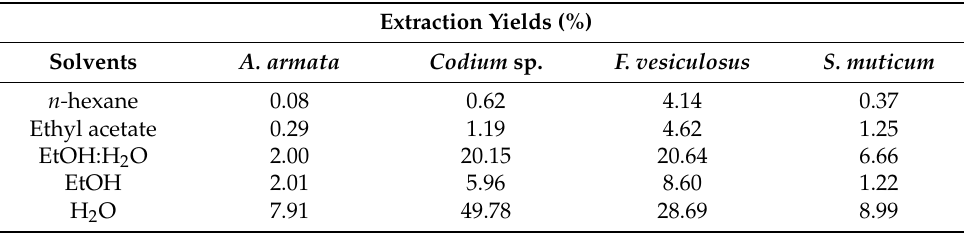
Table 1. Percentages of extraction yields of Asparagopsis armata , Codium sp., Fucus vesiculosus , and Sargassum muticum for the five different solvents used ( n -hexane, ethyl acetate, water, ethanol, and